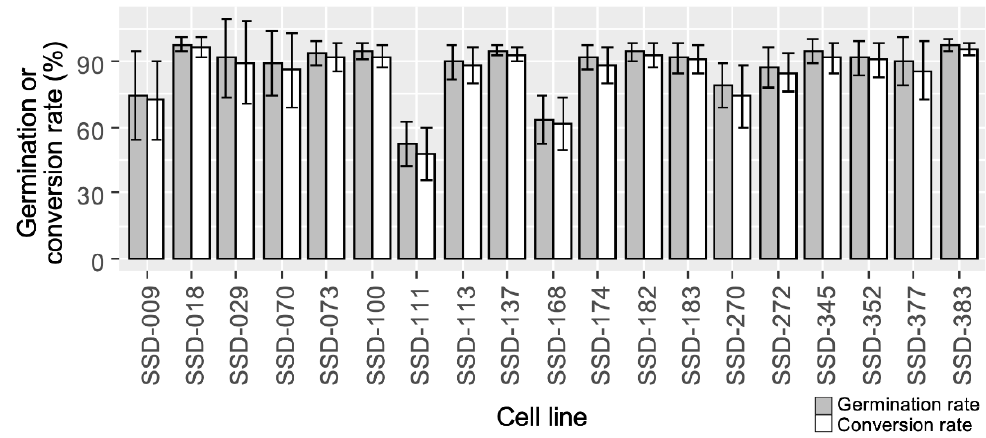
Figure 5. Cell line differences in germination and plantlet conversion of sugi (Japanese cedar, C. japonica ). The germination rate of somatic embryos (gray bars) and plantlet conversion rate (white bars) per each plate are presented as mean and standard deviation.